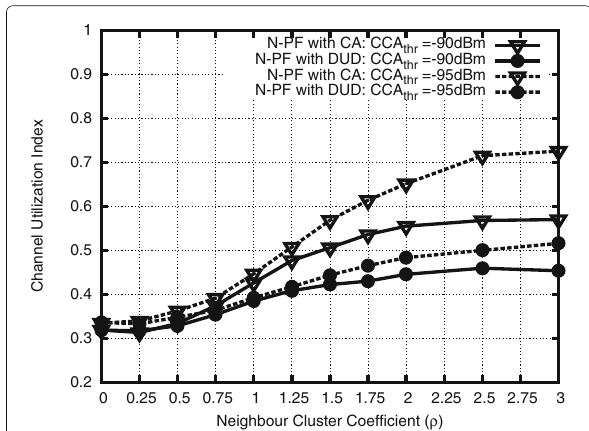
Fig. 12 Channel utilization index with CA and DUD algorithms, for K = 100, M = 100, and different values of CCA thr